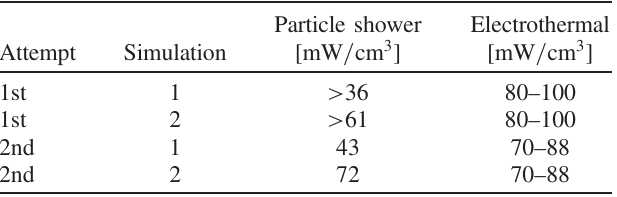
electrothermal MQPD estimate for the static orbit-bump quench test. Simulations 1 and 2 correspond to MAD-X models without and with an aperture restriction, respectively; compare with Fig. 22. The upper and lower values for the electrothermal estimate correspond to a cooling model with and without heat flow through the intralayer spacers,